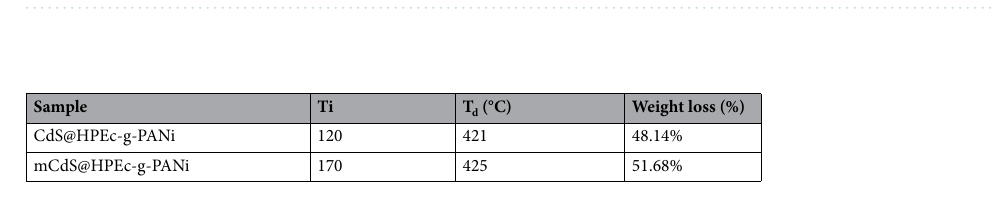
Figure 8. The TGA curves of the ( a ) CdS@HPEc-g-PANi and ( b ) mCdS@HPEc-g-PANi nanocomposites.